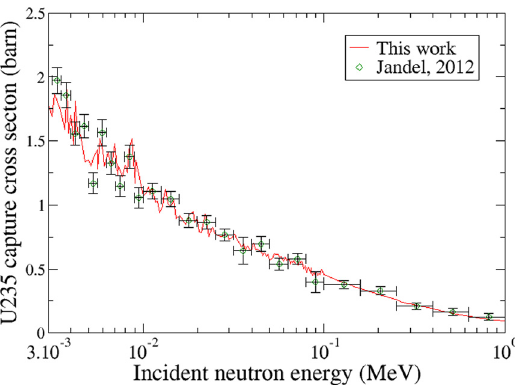
Fig. 9. Comparison of Jandel et al. measurements [16] to JEFF-